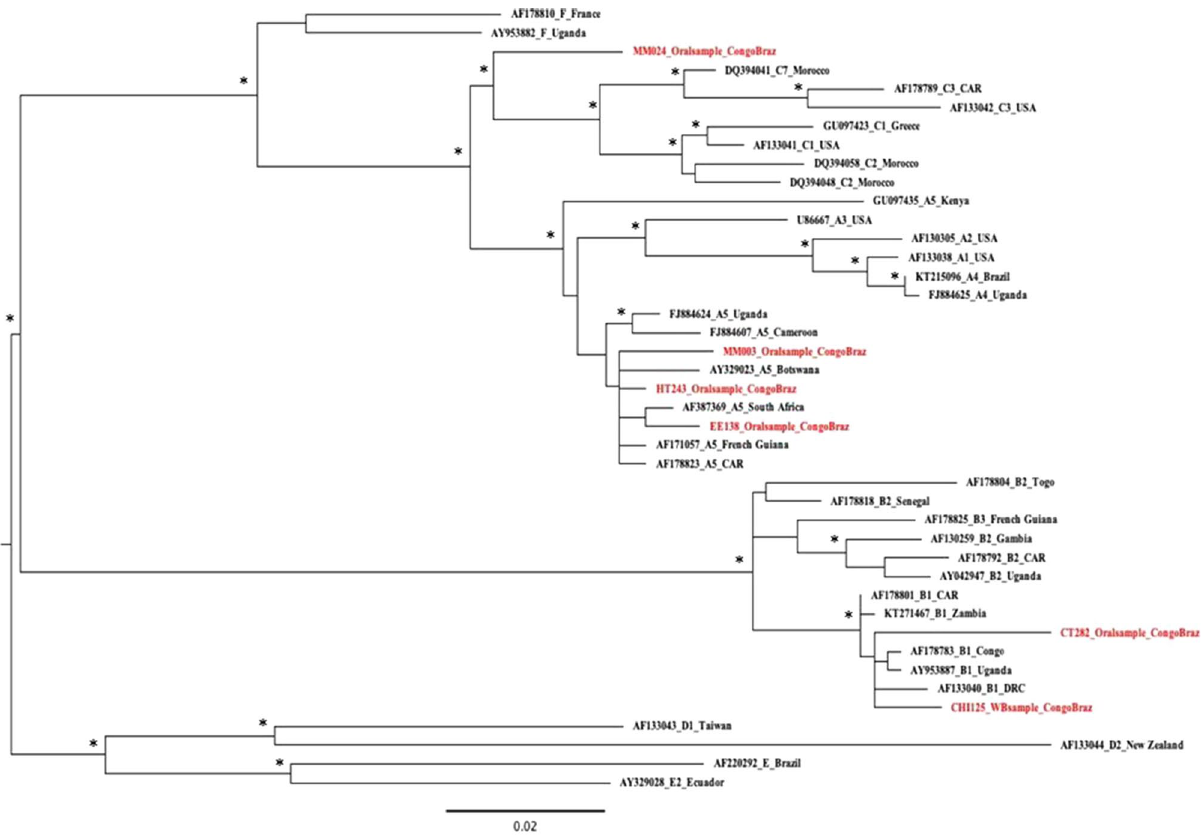
Figure 1. Maximum likelihood phylogenetic tree constructed with nucleotide ORF K1 sequences issued from patients with detectable HHV8-DNA viral load in saliva and whole blood sample. Tree was constructed with PhyML software (version 3.0) with the GTR model, four rate categories of gamma shape parameter and 1000 bootstrap resampling and visualized in FigTree (version 1.4.3. Patients’ sequences are shown in red, reference sequences from NCBI database in black and asterisks represent nodes with a bootstrap support > 70%. GenBank reference sequence accession numbers were as follow: A1: AF133038 (USA), A2: AF130305 (USA), A3: U86667 (USA), A4: KT215096 (Brazil), A4: FJ884625 (Uganda), A5: AF178823 (CAR), A5: FJ884607 (Cameroon), A5: AY329023 (Botswana), A5: FJ884624 (Uganda), A5: GU097435 (Kenya), A5: AF387369 (South Africa), A5: AF171057 (French Guiana), B1: AF133040 (Democratic Republic of the Congo), B1:AF178783 (Republic of Congo), B1: AF178801 (CAR), B1: AY953887 (Uganda), B1: KT271467 (Zambia), B2: AF178792 (CAR), B2: AY042947 (Uganda), B2: AF130259 (Gambia), B2: AF178818 (Senegal), B2: AF178804 (Togo), B3: AF178825 (French Guiana), C1: GU097423 (Greece), C1: AF133041 (USA), C2: DQ394048 (Morocco), C2: DQ394058 (Morocco), C3: AF178789 (CAR), C3: AF133042 (USA), C7: DQ394041 (Morocco), D1: AF133043 (Taiwan), D2: AF133044 (New Zealand), E: AF220292 (Brazil), E2: AY329028 (Ecuador), F: AY953882 (Uganda), F : AF178810 (France). GenBank new sequence accession numbers were as follows: HT243_Oralsample_ CongoBraz: MW892531; EE138_Oralsample_CongoBraz: MW892532; MM003_Oralsample_CongoBraz: MW892533; MM024_Oralsample_CongoBraz: MW892534; CHI125_WBsample_CongoBraz: MW892535; CT282_Oralsample_CongoBraz: